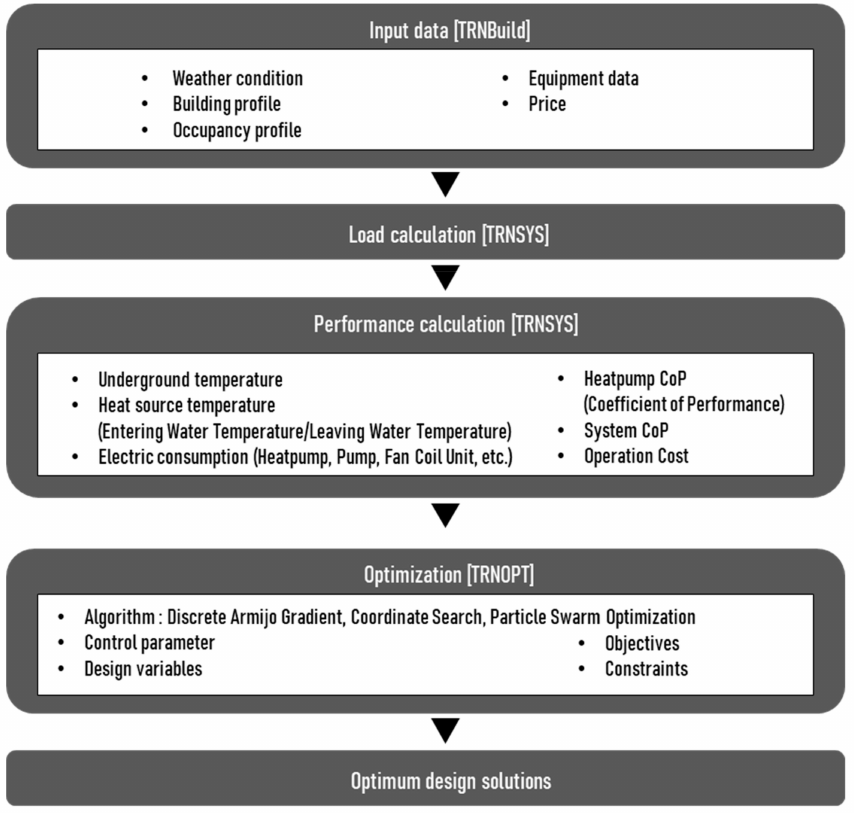
Figure 2. Design methods of the optimal GSHP